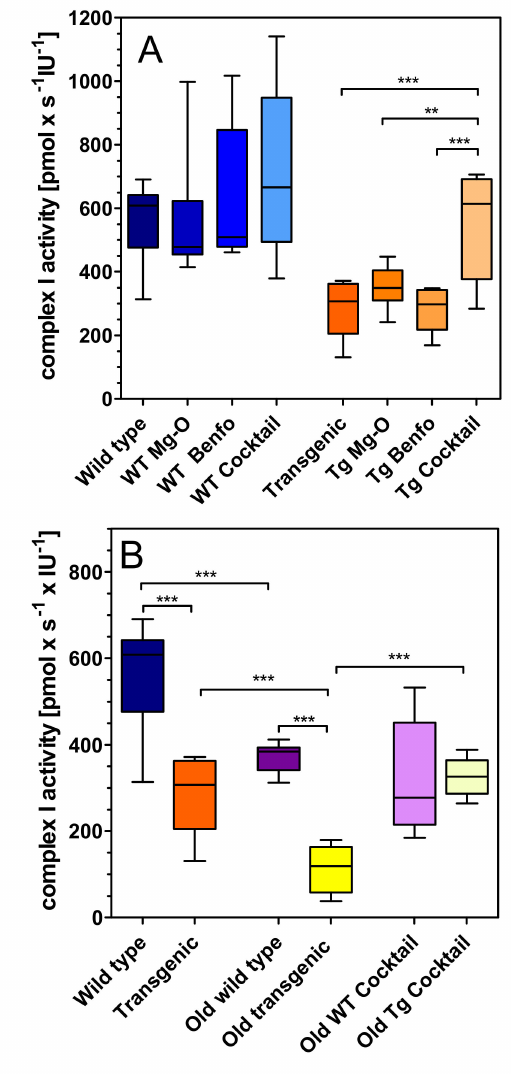
Figure 2. Oxygen flux of complex I in ( A ) young wild-type and transgenic rats and ( B ) young and old rats treated with cocktail. Substrates, uncoupler and inhibitors were used to measure complex I as described in methods. Raw data were normalised to mitochondrial citrate synthase activity. A: (left) Treatment in wild type (WT), (right) treatment in transgenic (Tg) animals. Statistical analysis: Data are box plots (lower and upper quartile) with whiskers ( n = 8–10) and were analysed by one-way ANOVA followed by Bonferroni’s multiple comparison test: (a) F3,34 = 0.96, p = 0.43; (b) F3,31 = 11.78, p < 0.001. ** p < 0.01, *** p < 0.001 B: Genotype, treatment and age related effects. Statistical analysis: Data are box plots (lower and upper quartile) with whiskers ( n = 8–10) and were analysed by unpaired t -test. *** p <